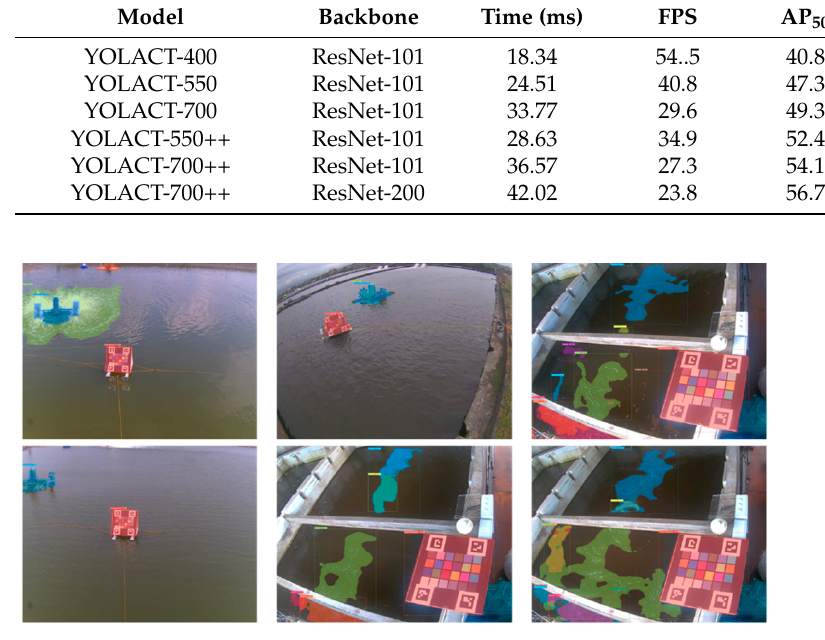
Figure 15. Results of image segmentation from different scenes at three sites.